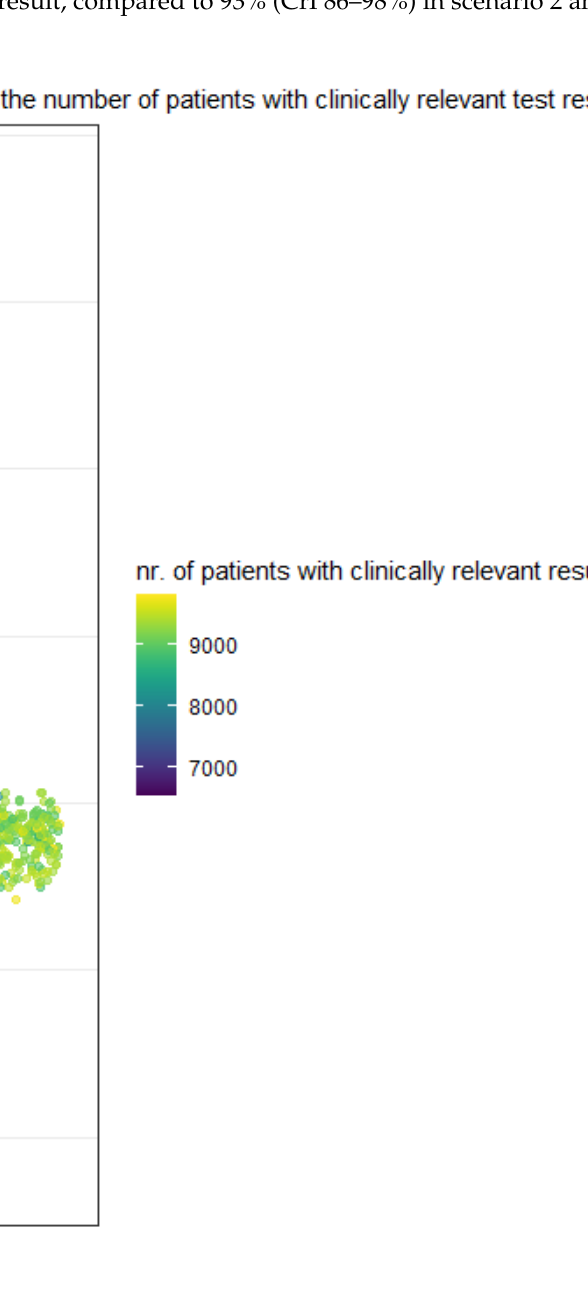
Figure 2. PSA outcomes: Means costs per run. One dot represents the mean costs of one run with 10,000 cases. The higher the number of cases with a clinically relevant result, the lighter the dot. Red = Mean total costs of all runs.